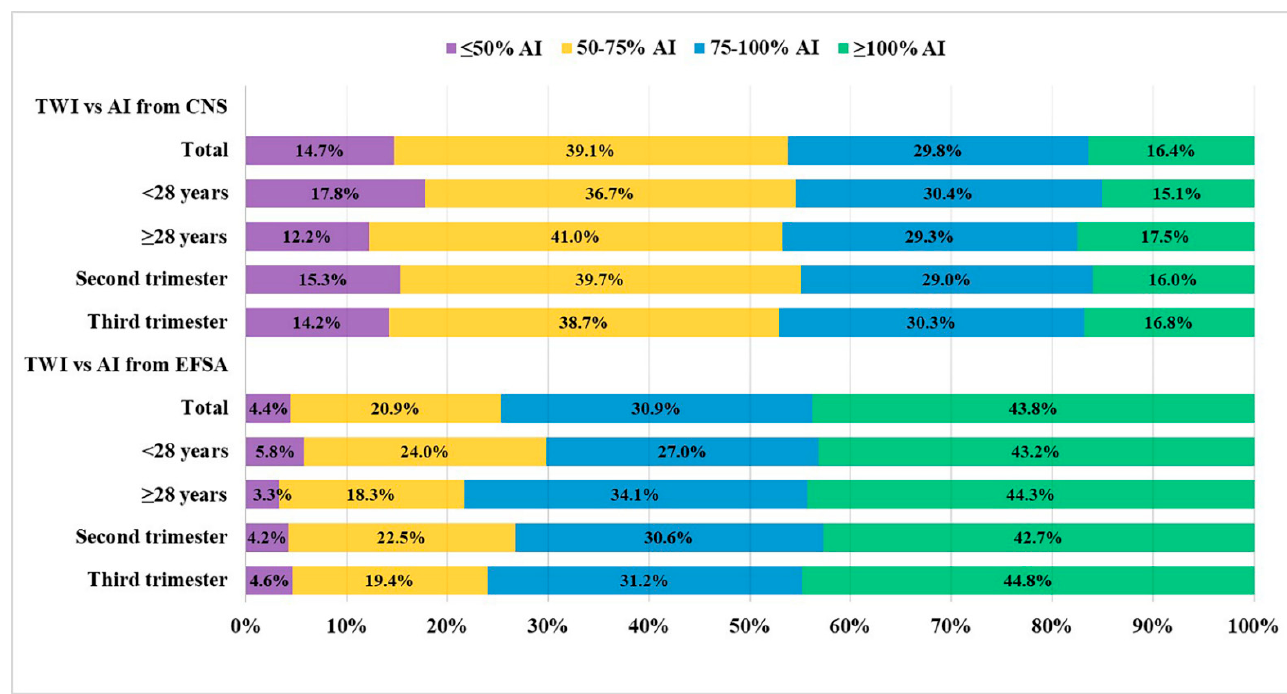
Figure 1. Percentages (%) of Chinese pregnant women in 2018 according to adherence categories of adequate intakes of total water intake set by the Chinese Nutrition Society or European Food Safety Authority categorized by age and gestational trimesters. AI: adequate intake; TWI: total water intake; CNS: Chinese Nutrition Society; EFSA: European Food Safety Authority.